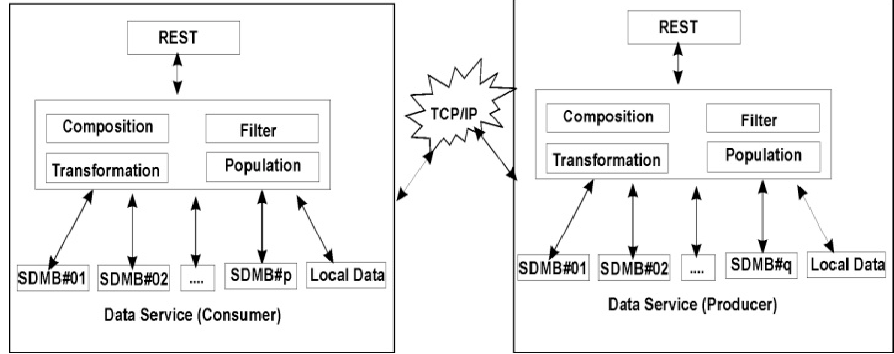
Figure 2. Model of Structured Data REpresentational State Transfer (REST) (SDRest) Protocol.